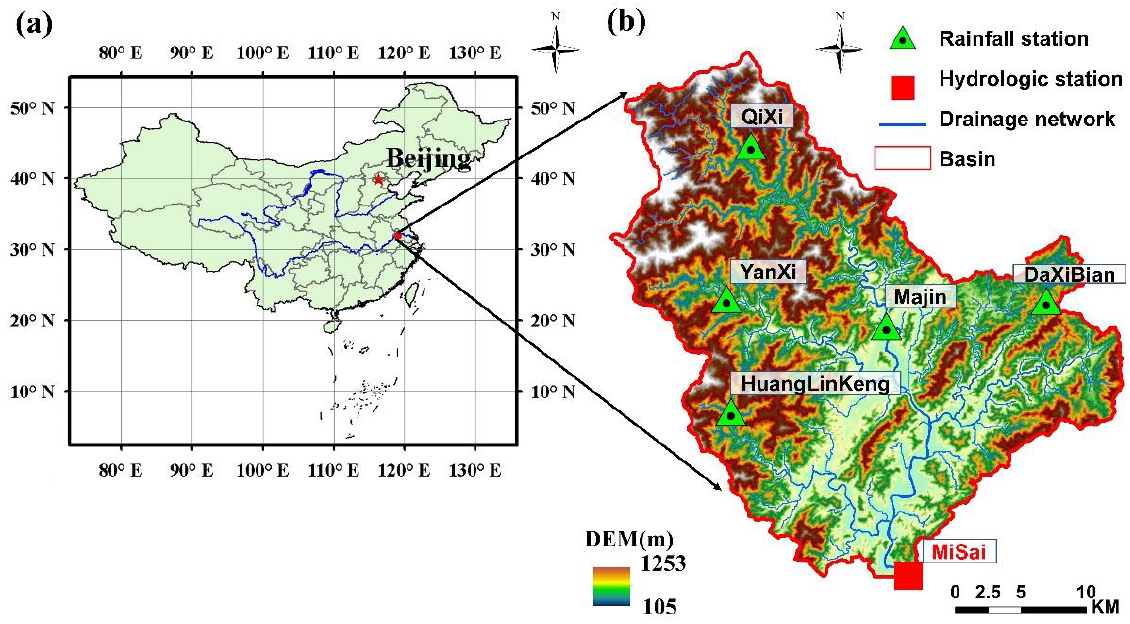
Figure 1. Location of Misai watershed and relevant hydrological information (( a ) Location of Misai watershed; ( b ) Hydrological information of Misai watershed).